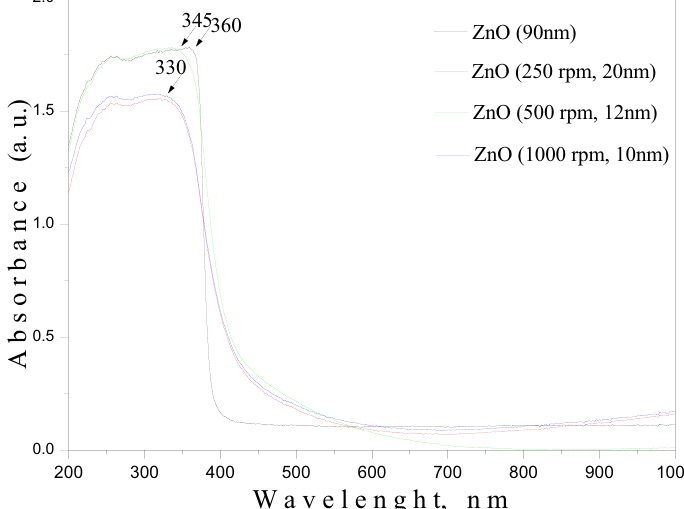
Figure 5. UV-Vis absorption spectra of initial ZnO and ZnO mechanically activated at different milling speeds (250, 500 and 1000 rpm).